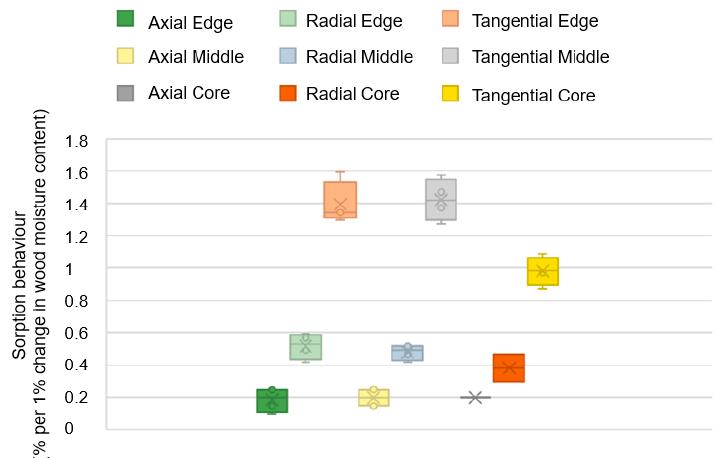
Figure 9. Sorption behavior in the axial, radial, and tangential direction of Paulownia samples extracted from the edge, middle, and from the core of the tree.